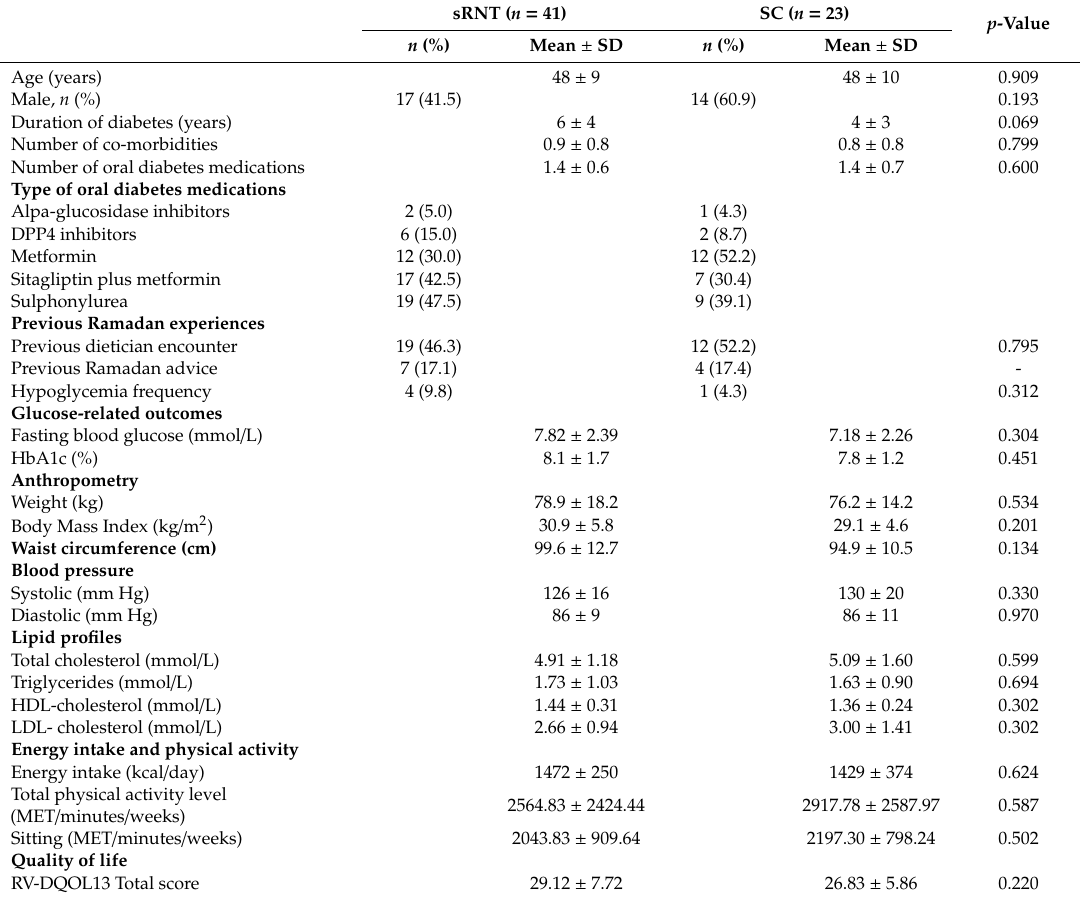
Table 2. Baseline characteristics of the participants ( n =